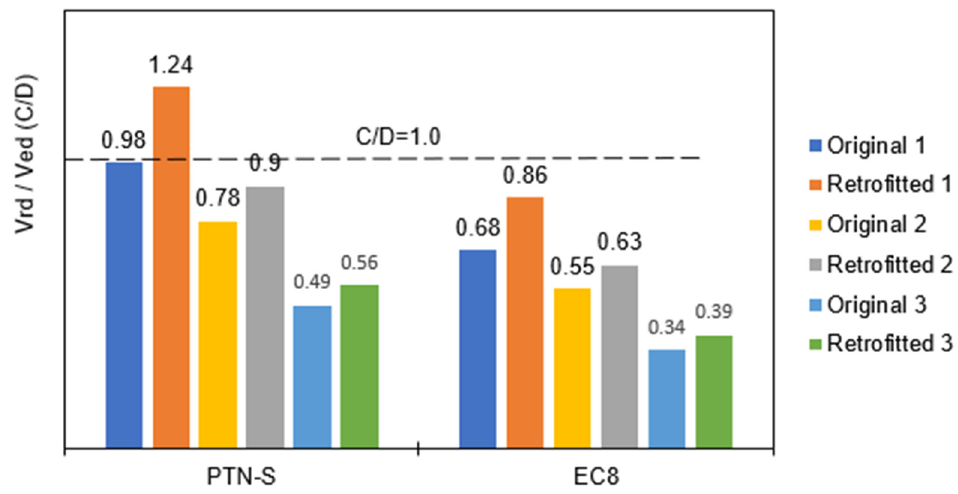
Figure 29. Seismic capacity versus demand (C/D) ratio in the analyzed wall for the original and retrofitted building.